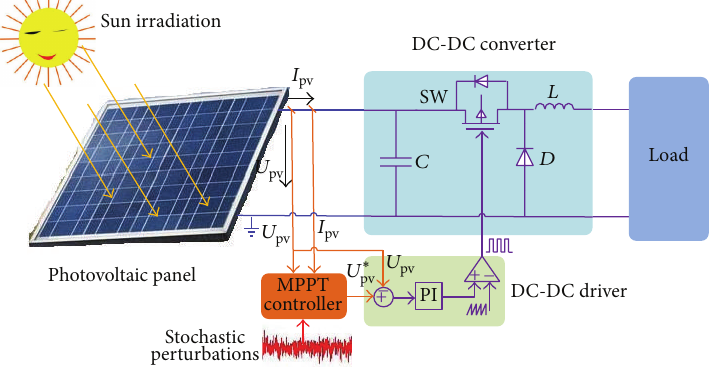
Figure 3: The schematic of a photovoltaic MPPT control system with stochastic perturbations.